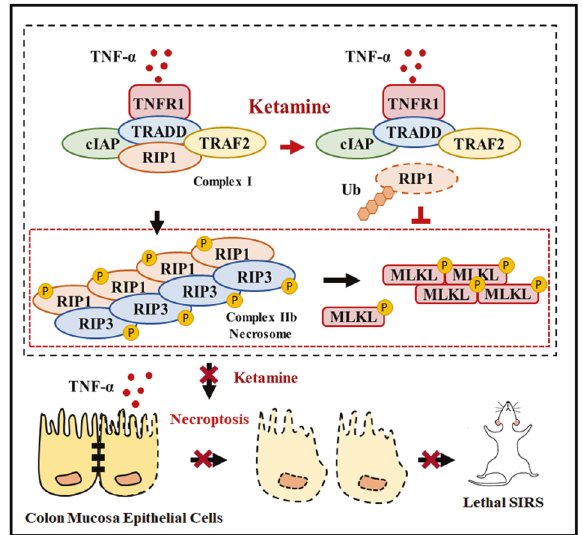
Fig. 9 Schematic diagram summarizing the proposed mechanism by which ketamine alleviates the lethal systemic in fl ammatory response by inhibiting cecal damage through promoting RIP1 ubiquitination. The pathogenesis of TNF- α -induced SIRS is asso- ciated with cecal damage via RIP1-, RIP3-, and MLKL-related signaling pathways. Interestingly, we found that ketamine ef fi ciently inhibited TNF- α -induced cecal damage by enhancing RIP1 ubiqui- tination and reducing RIP1-RIP3 and RIP3-MLKL interactions, as well as the formation of necrosomes, which was bene fi cial for attenuat- ing lethal